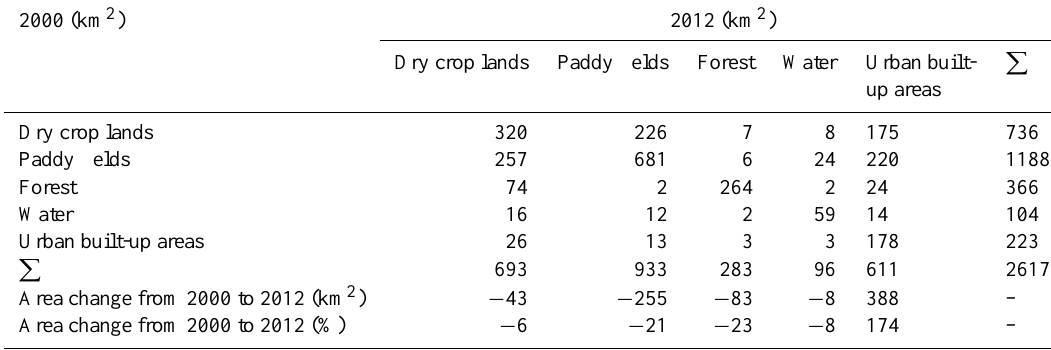
Table 2. The conversion matrix for land-use change during 2000–2012 in the Qinhuai River basin.